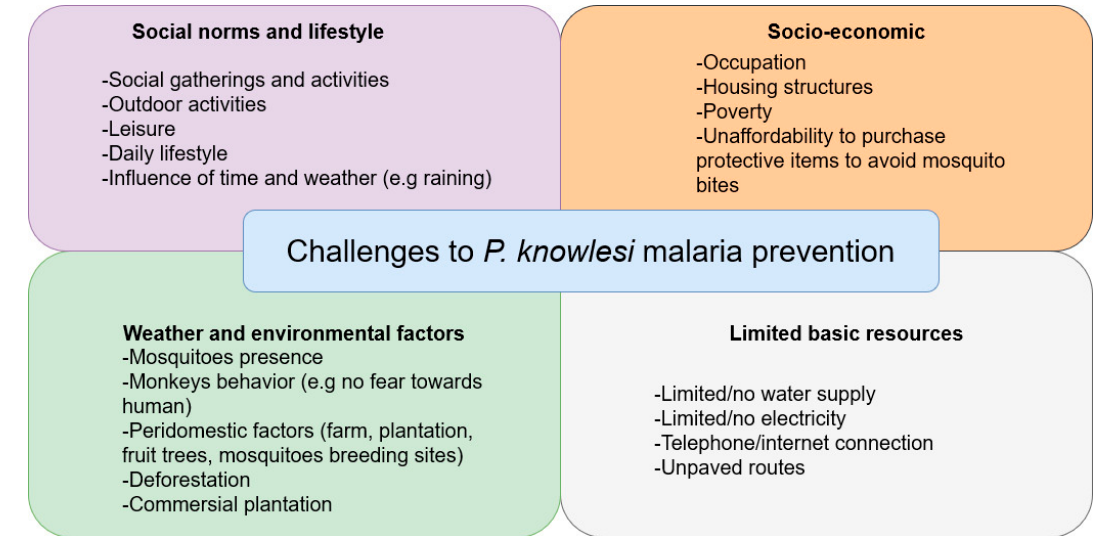
Figure 6. Challenges to avoid malaria infection based on the perspective of gatekeepers.